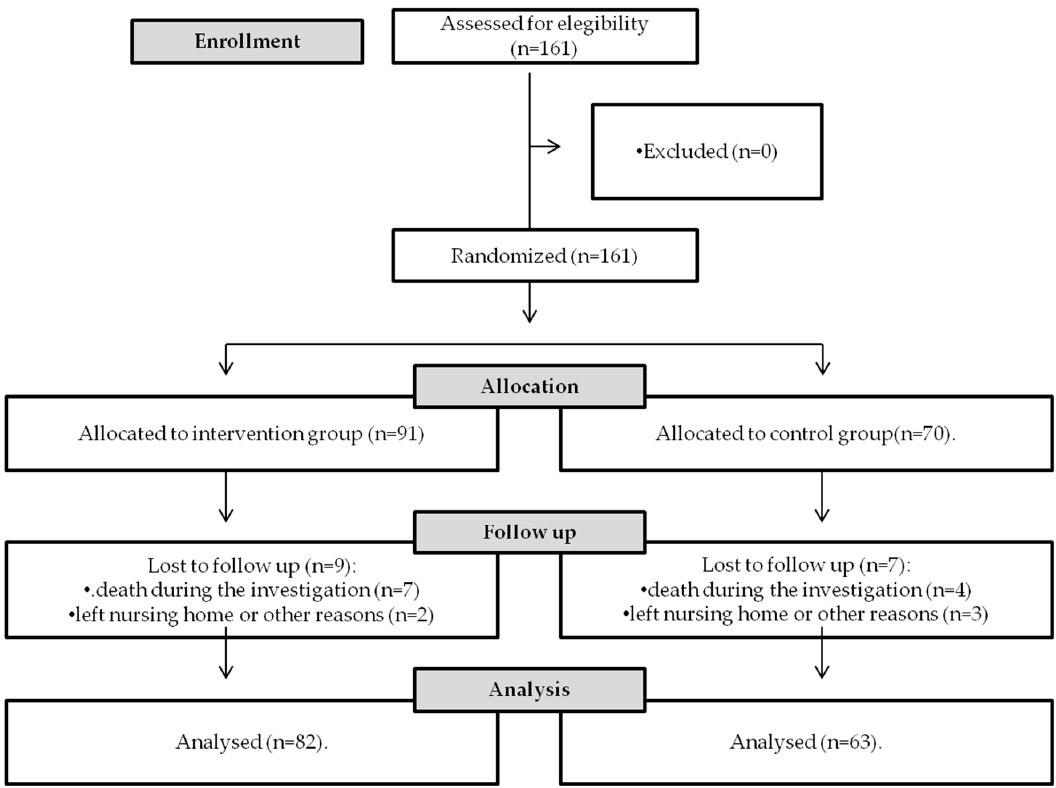
Figure 1. CONSORT diagram.